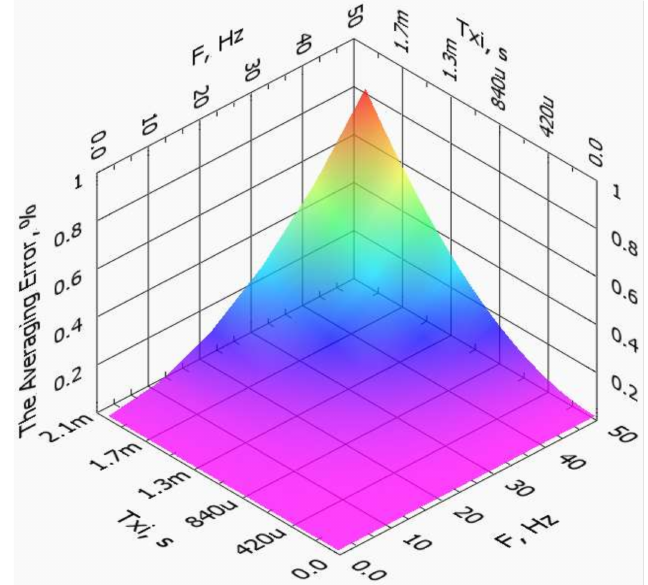
Figure 4. An example of the averaging error for the period of the tested signal changing in the range from 0 to 2 ms and the frequency F of the x ( t ) waveform varying in the range from 0 to 50 Hz.